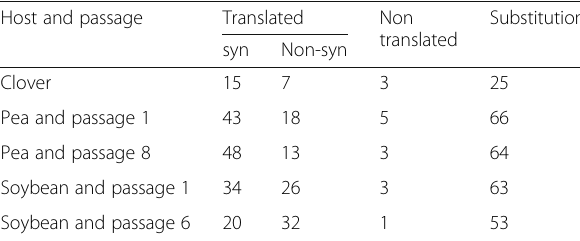
Table 3 Types of mutations observed in SbDV-MD6 populations in different host species and passages